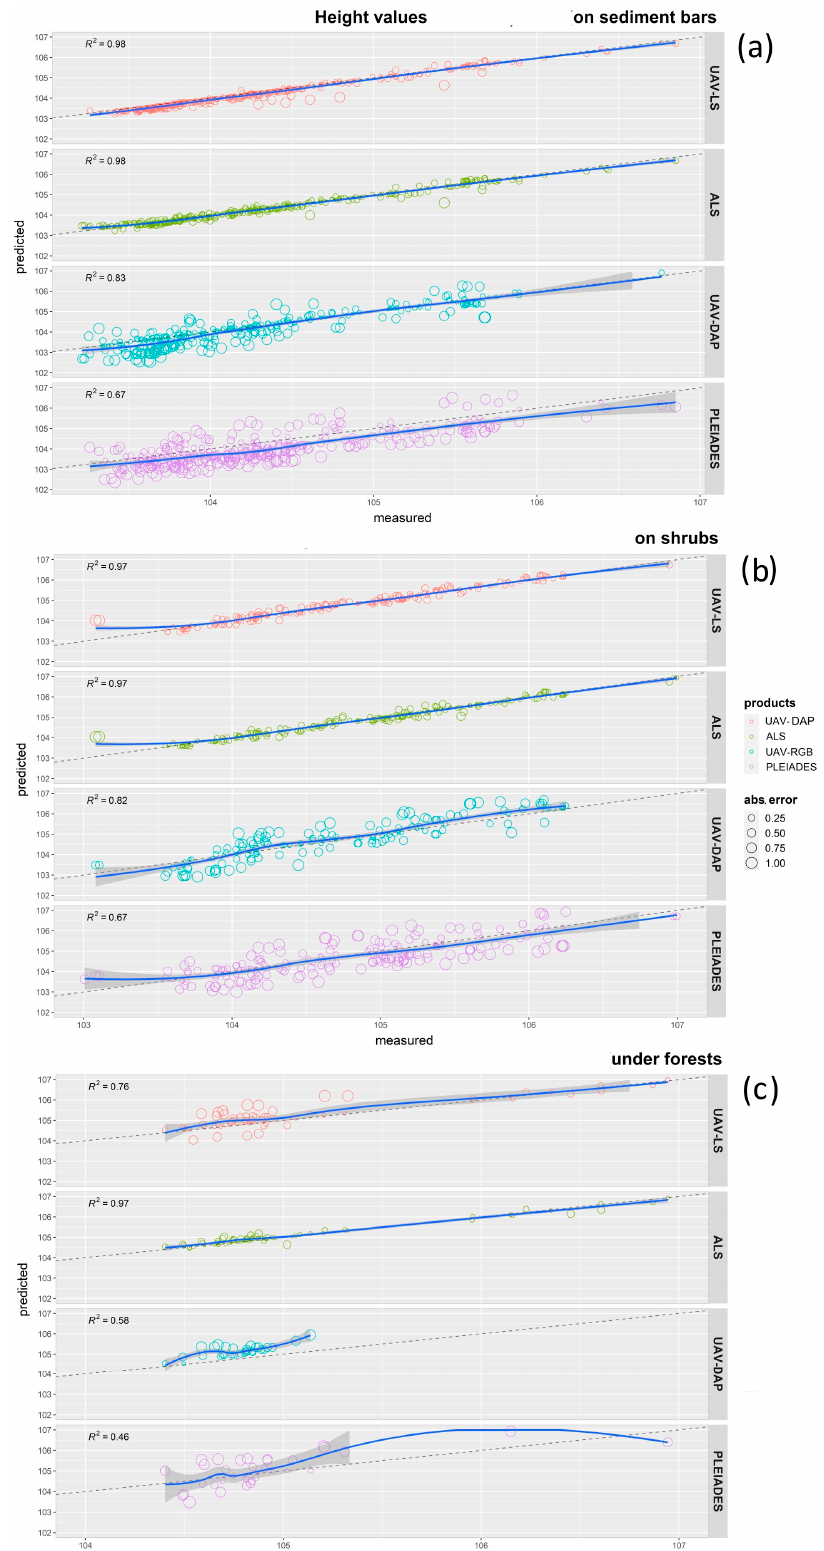
Figure 11. Sca tt erplots of height values generated on DTM according to di ff erent data sources (from top: UAV-LiDAR, ALS—airborne LiDAR, UAV—RGB photogrammetry, satellite images from Pléiades), and according to land cover classes (( a )—uncovered sandbars, ( b )—shrub vegetation, ( c )—riparian forest). The measurement values are in meters, WGS84 ellipsoidal (geodetic) heights.